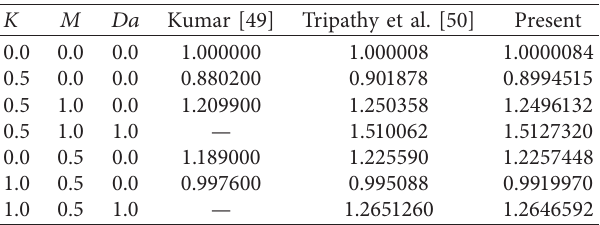
Pr as compared with x for variations in